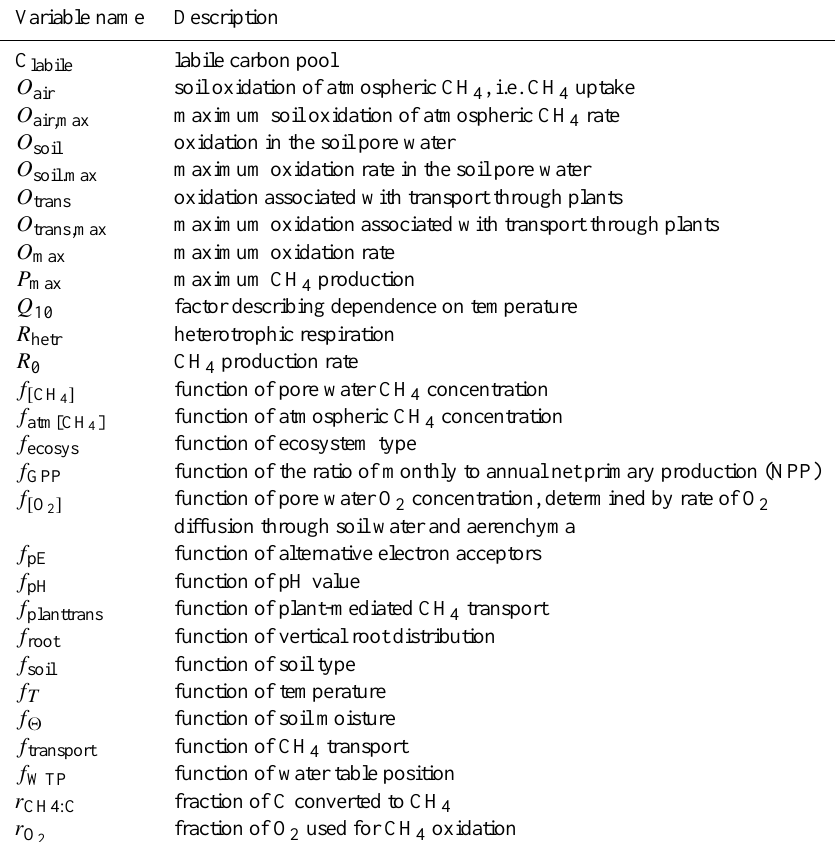
Table 6. Explanation of variable names used in Table